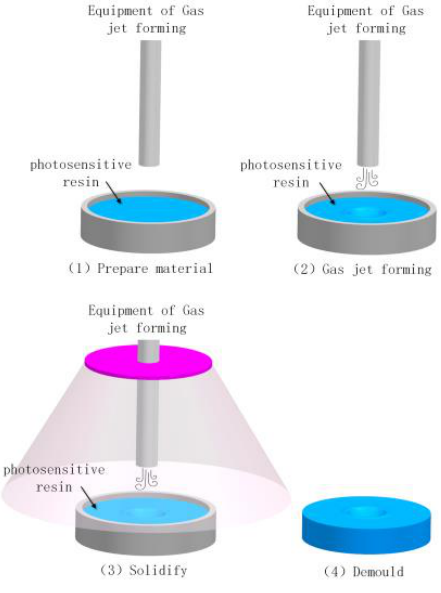
Figure 10. Schematic diagram of the process of the gas jet forming.